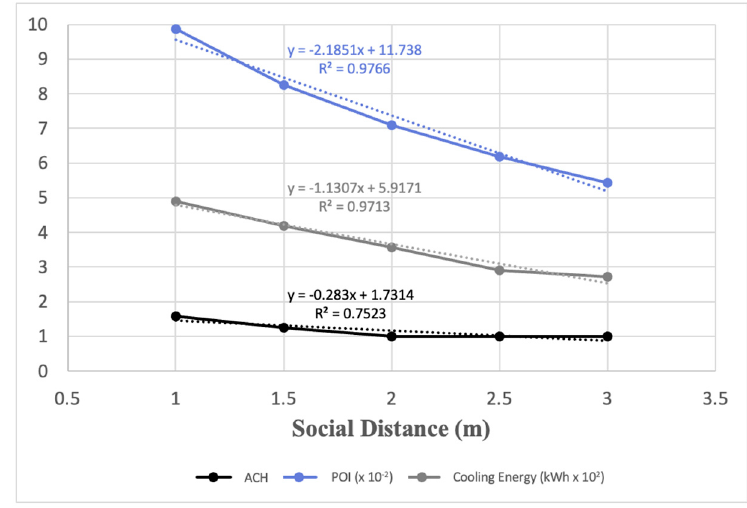
Figure 15. Variations in POI, cooling energy, and ventilation rate with the social distance for the one infector case using DCV system.